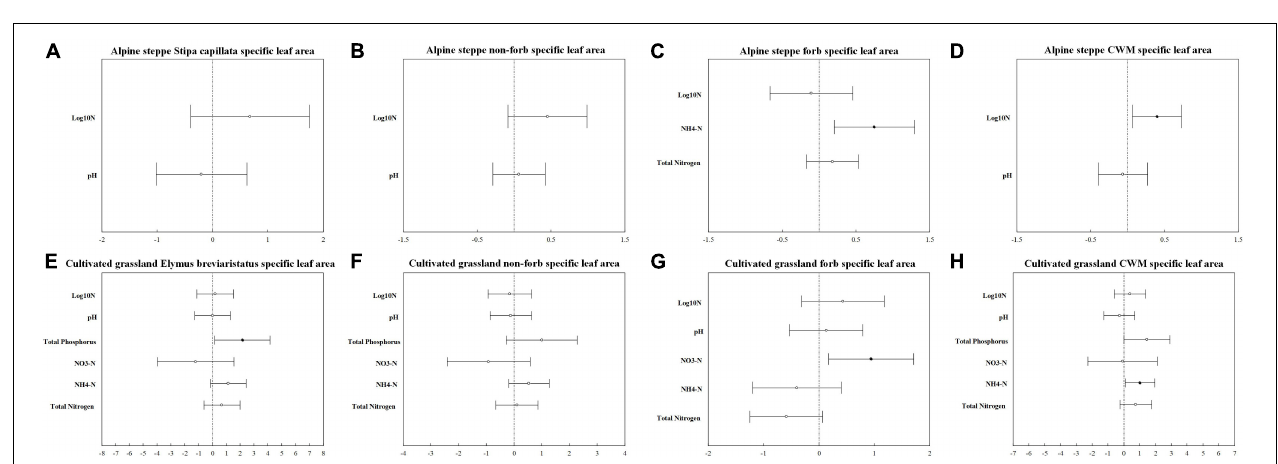
FIGURE 3 | Standardized parameter estimates ( ± 2 SE) of log 10 nitrogen addition gradients, pH, available phosphorus, total phosphorus NH 4 -N, NO 3 -N, and total nitrogen for Stipa capillata SLA (A) , non-forb SLA of alpine steppe (B) , forb SLA of alpine steppe (C) , community-weighted mean value of SLA of alpine steppe (D) , Elymus breviaristatus SLA (E) , non-forb SLA of cultivated grassland (F) , forb SLA of cultivated grassland (G) , and community-weighted mean value of SLA of cultivated grassland (H) . Filled circles indicate significant effects ( p < 0.05).